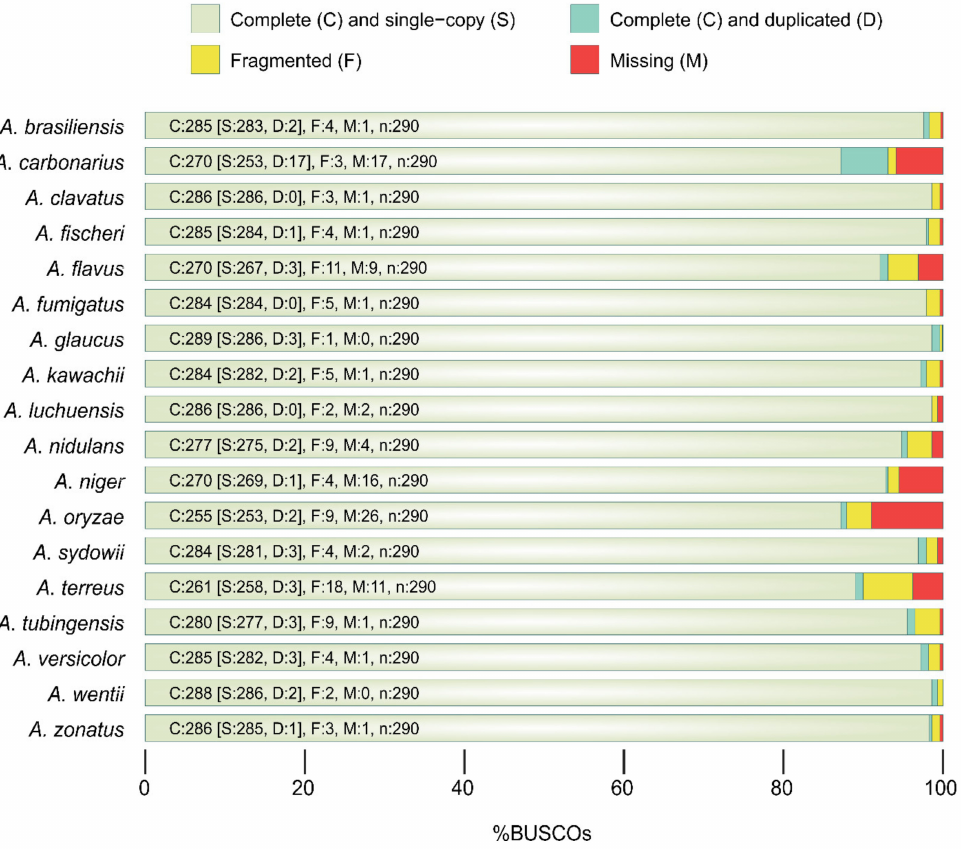
Figure 1. Genome completeness in the Aspergilli compared. Statistics and assessment of Aspergilli protein-coding gene sets and their completeness in BUSCO notation (C: complete (S: single copy) and (D: duplicated); F: fragmented; M: missing; n: gene